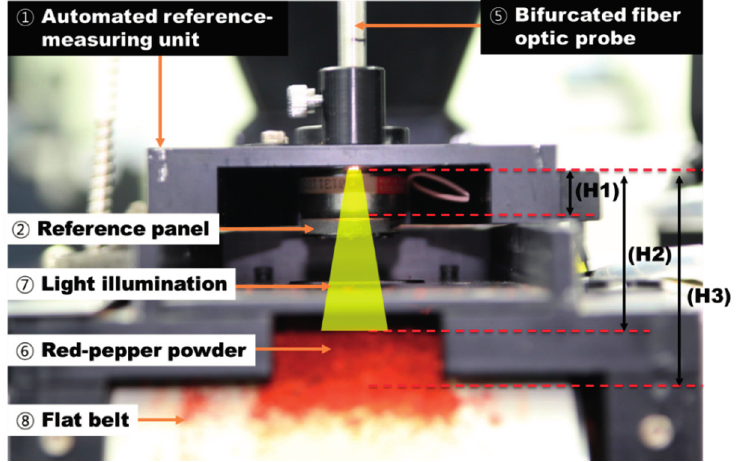
Figure 9. H1: End of optic probe to reference panel surface; H2: End of optic probe to red pepper powder surface; H3: End of optic probe to conveyor belt surface.